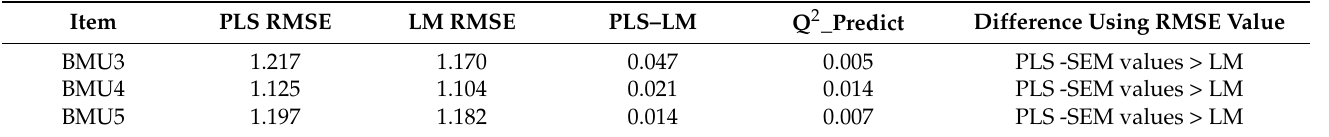
Table 8. PLS predict , results report.